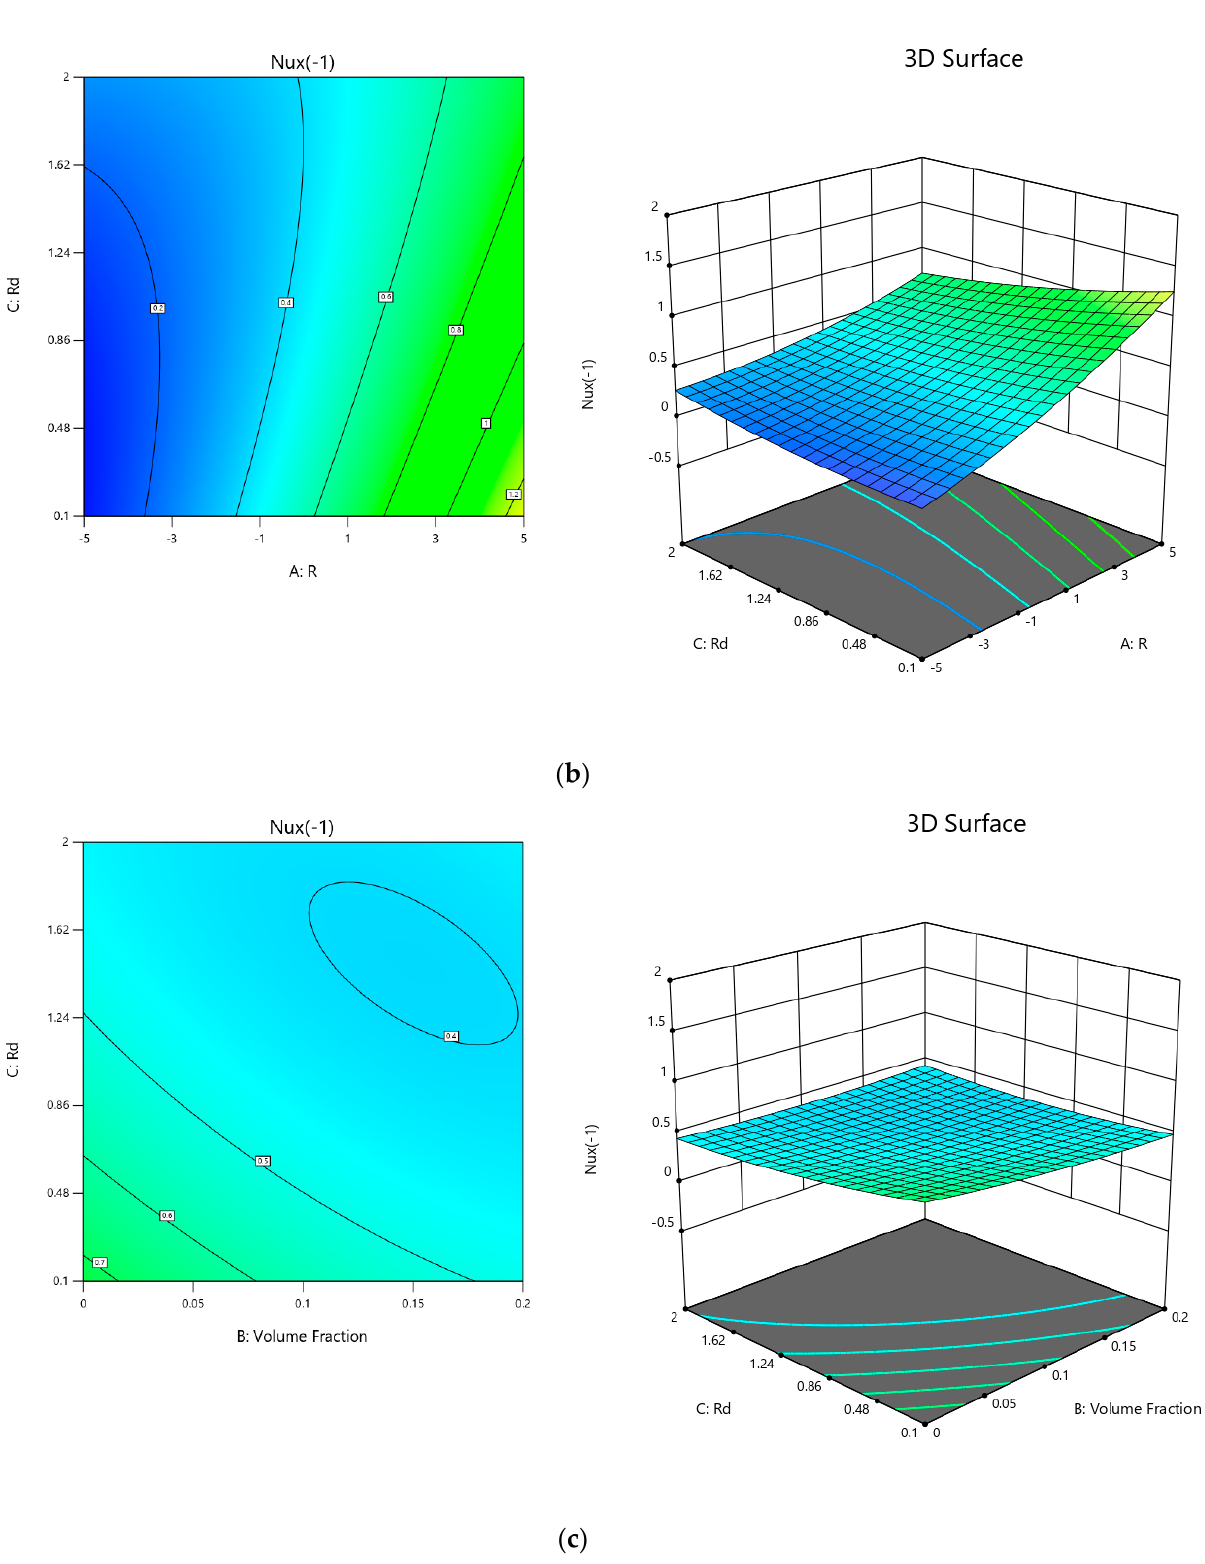
Figure 15. Three-dimensional surfaces and contour plots for all continuous parameters of R, Phi, and Rd on Nux.